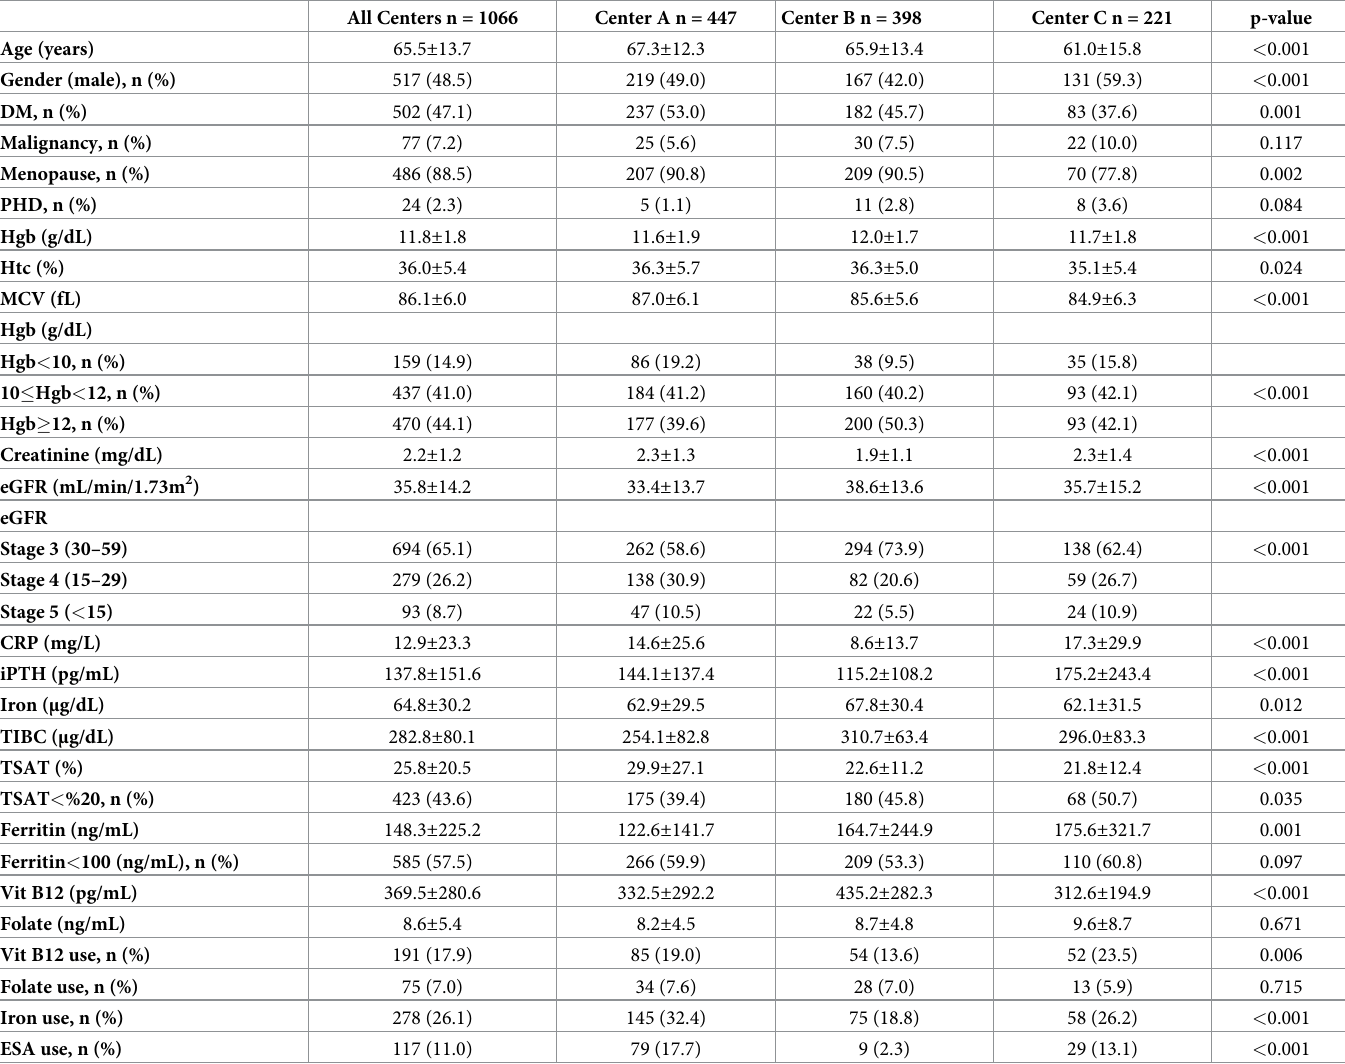
Table 1. General characteristics of the patients according to the